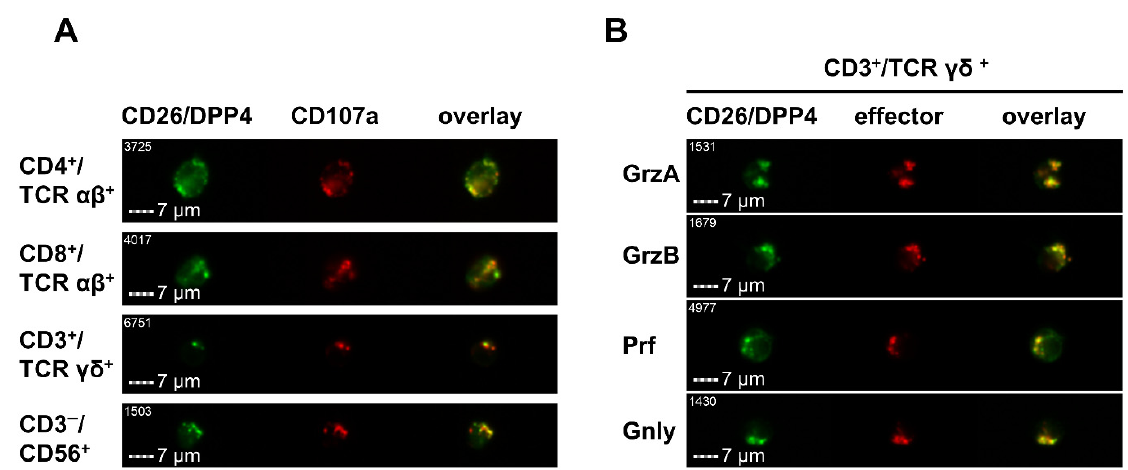
Figure 2. Intracellular storage of CD26 in cytotoxic effector lymphocytes. Co-localization of intracellular CD26 with ( A ) the lysosomal and degranulation marker protein CD107a (Lamp-1) in CD4 + /TCR αβ + , CD8 + /TCR αβ + , CD3 + /TCR γδ + , and CD3 − /CD56 + cells and ( B ) the cytotoxic effector proteins granzyme A (GrzA), granzyme B (GrzB), perforin (Prf), and granulysin (Gnly) in CD3 + /TCR γδ + cells.